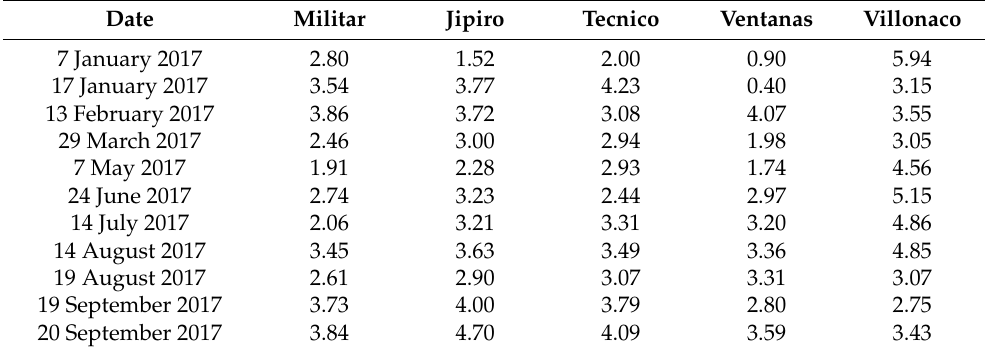
Table 4. ETo values for the selected dates at the existing stations in the study